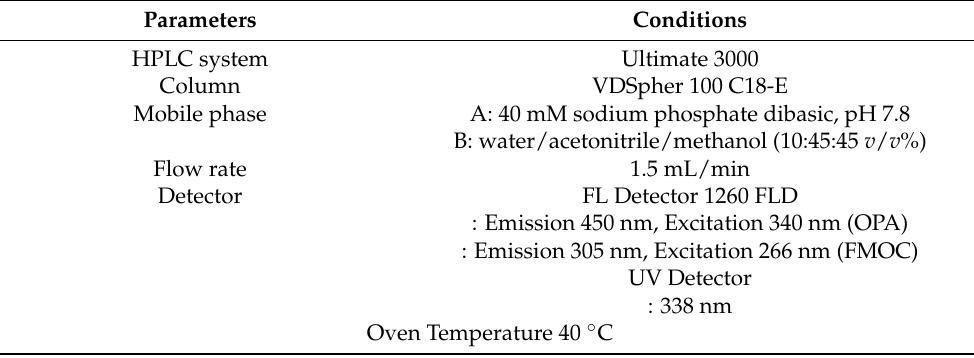
Table 1. Operational conditions for high-pressure liquid chromatography (HPLC) analysis to quantify free amino acid